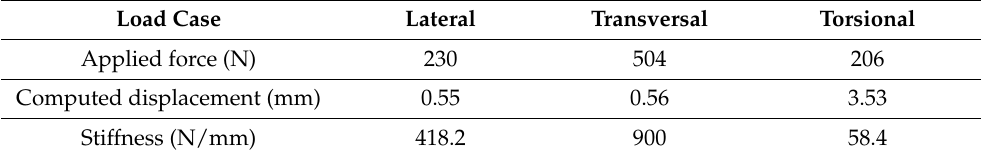
Table 12. Computed displacements and stiffnesses of the composite hood “B”.